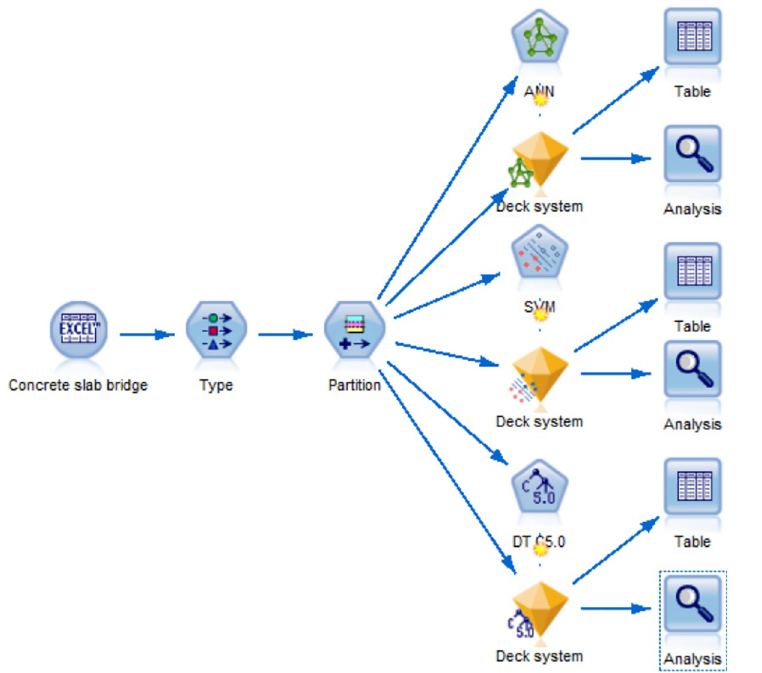
Fig 1. Prediction model of deterioration state of concrete slab